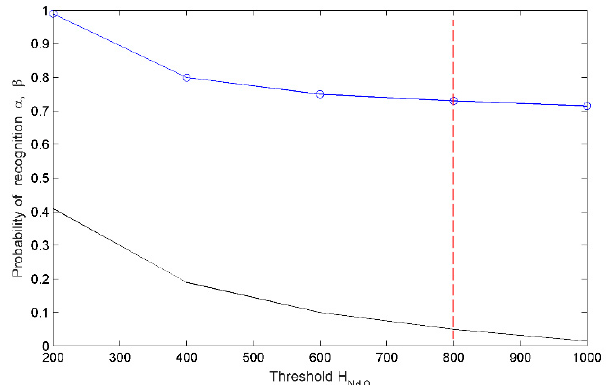
Figure 3. Estimated probability of correct (blue line with circles) and false (black line without circles) SC recognition. The red dashed line shows the optimal threshold value.